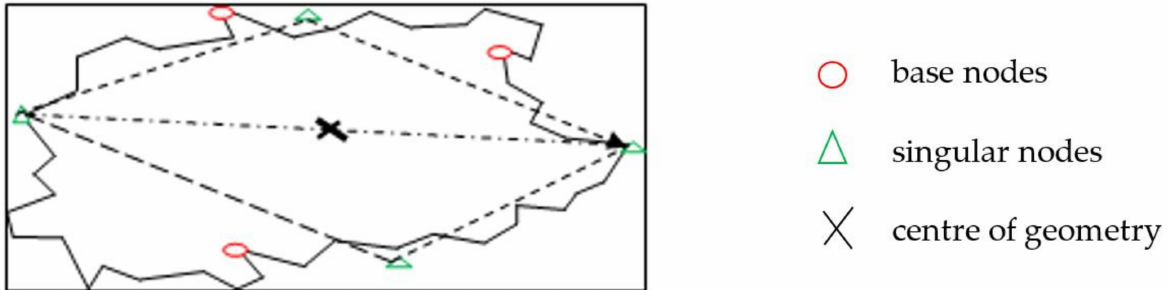
Figure 1. Cartographic control points of an aerial